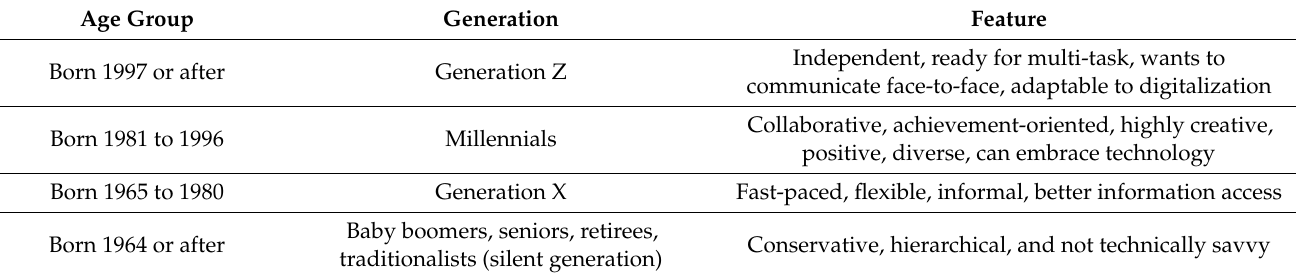
Table 2. Potential Omni-channel Customer